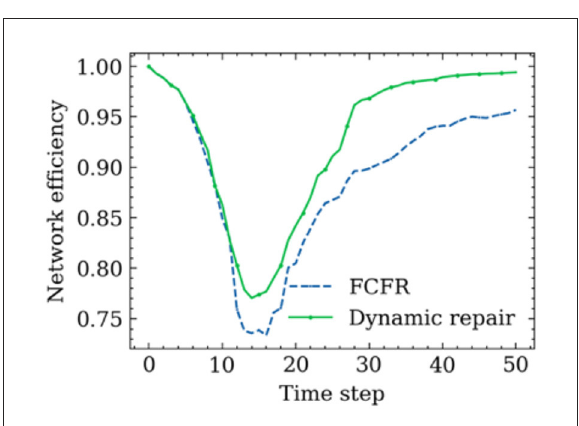
FIGURE11 Hybrid influence of restriction and reopen influence of the different recovery